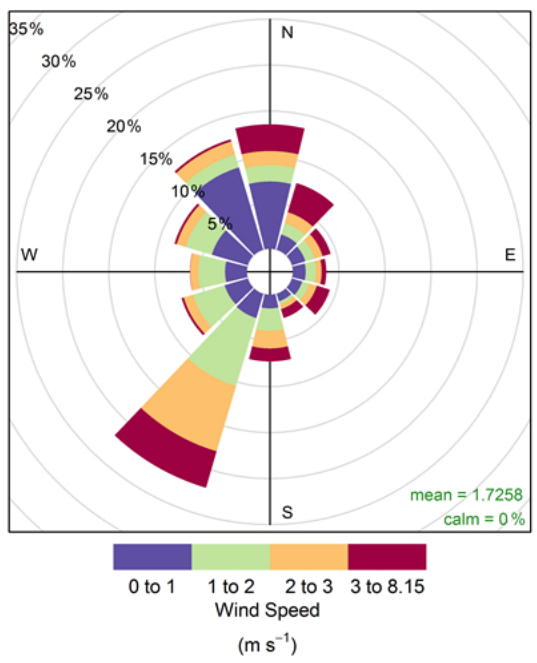
Figure 2. Wind speed and direction during the ambient air